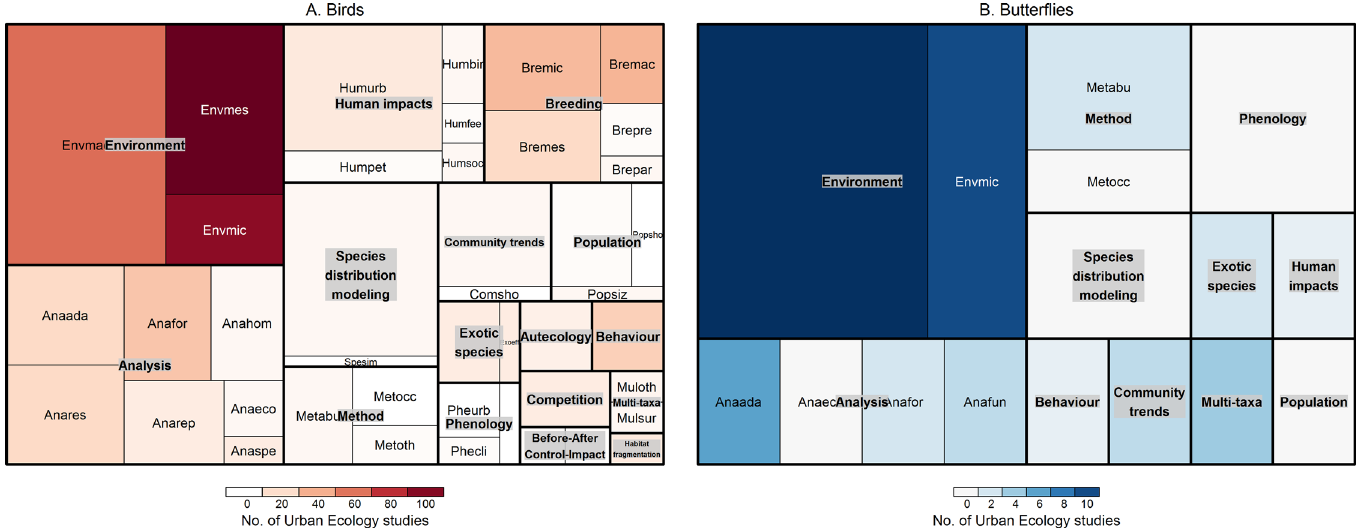
Fig 3. Hierarchical tree map contrasting the relative popularity of research theme categories addressed with CS datasets to that of the wider UE literature for birds (a) and butterflies (b): the size of the boxes represents the relative popularity of each category amongst CS datasets, while the shading represents the relative popularity of each category out of the overall UE dataset.